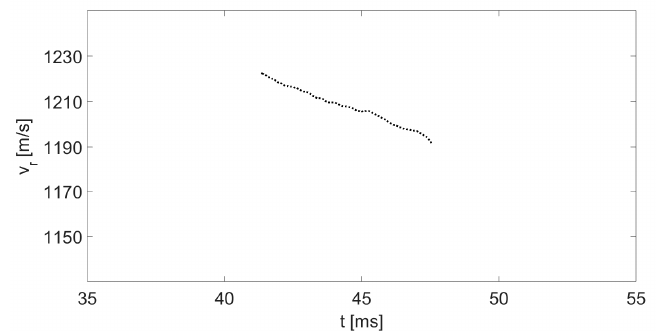
Figure 7. The instantaneous velocity of the fired bullet as a function of time.